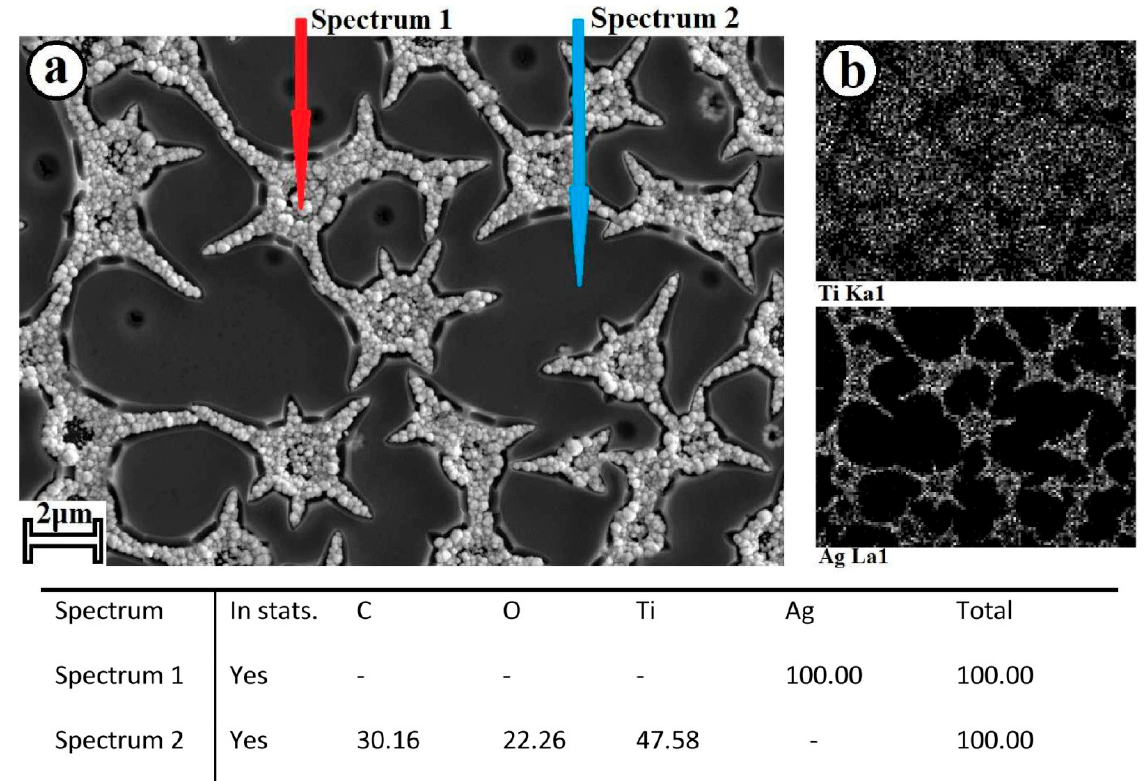
Figure 3. SEM image of ( a ) the TiO 2 /Ag composite; and ( b ) the element maps of the Ti and Ag in composite.